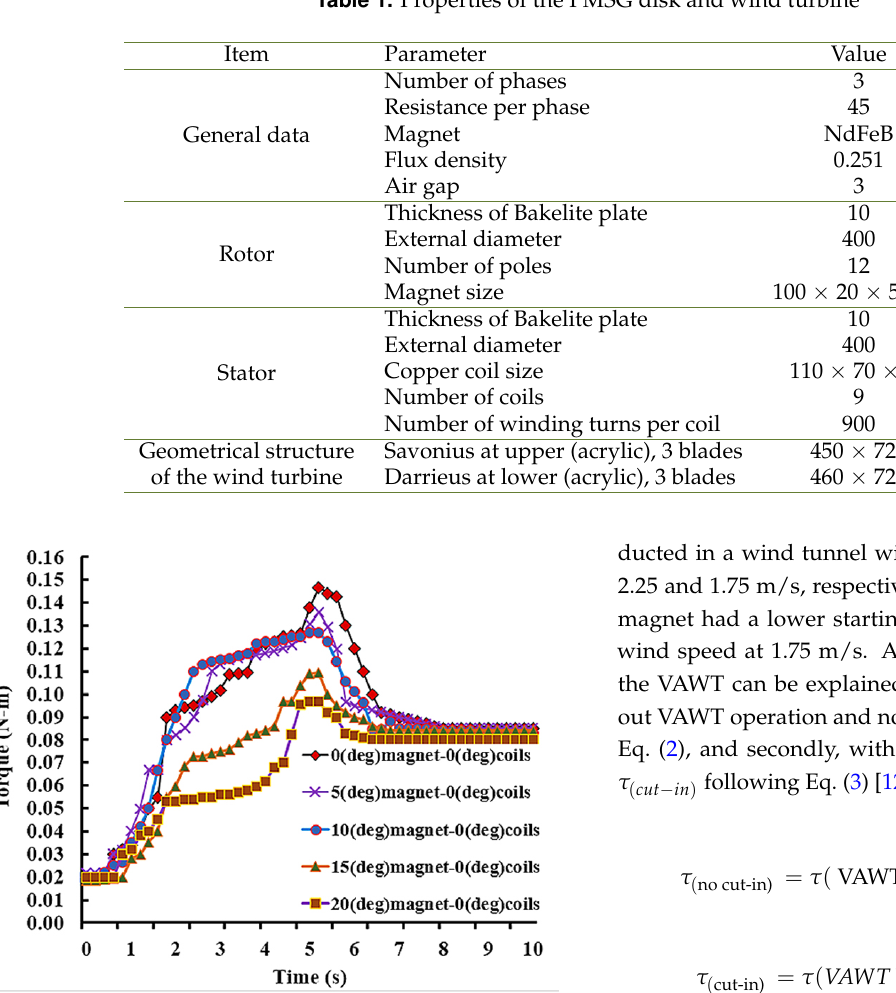
Table 1. Properties of the PMSG disk and wind turbine